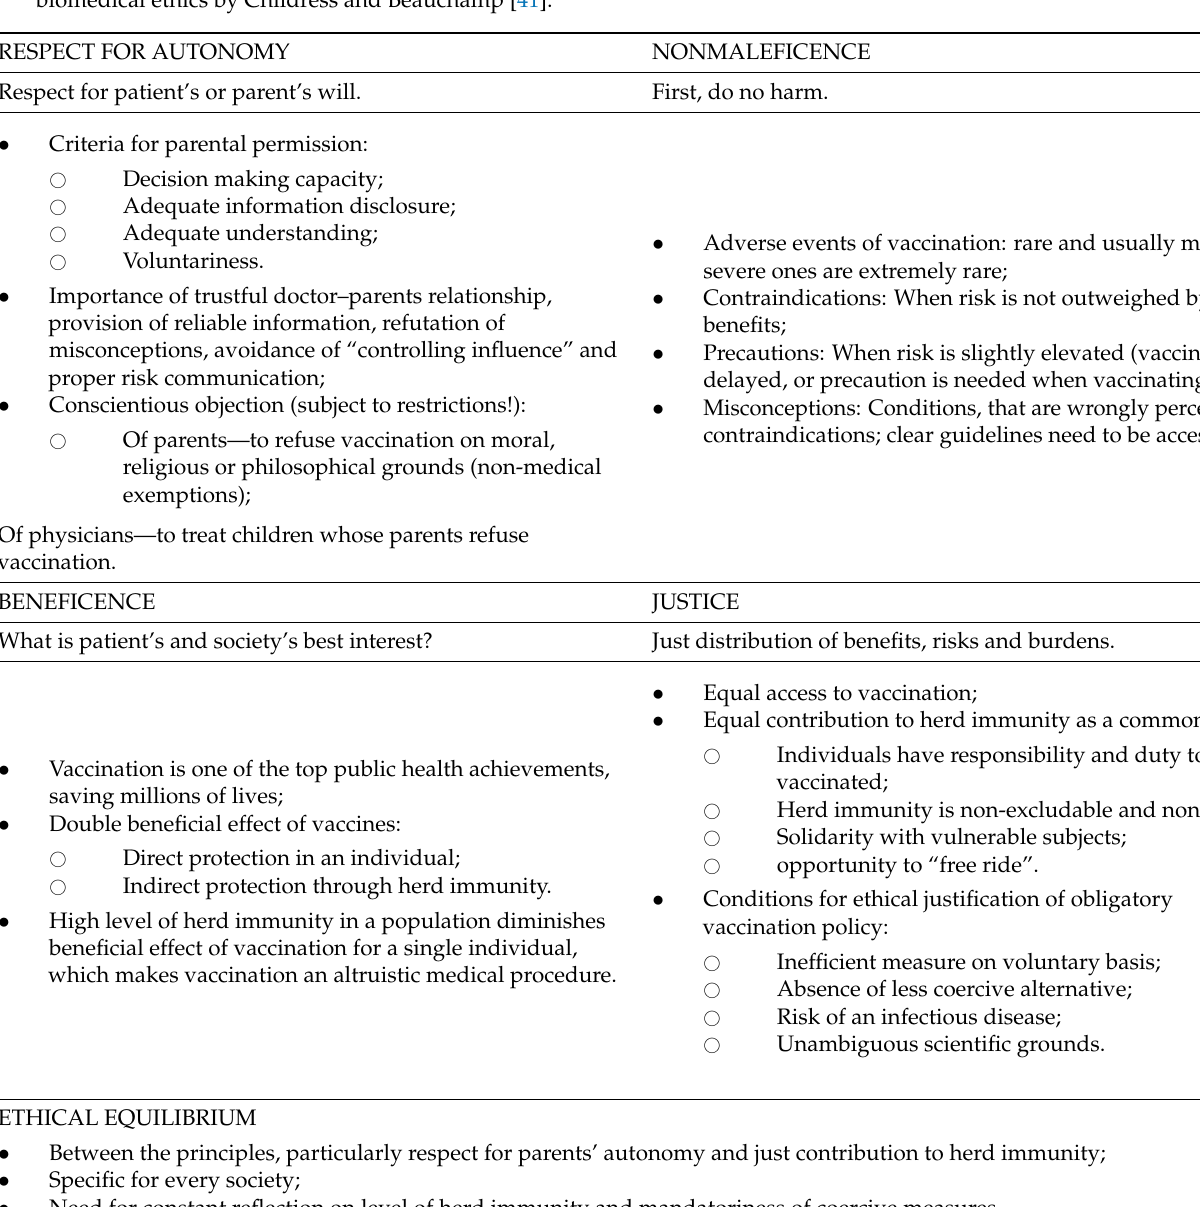
Table 1. A summary of a framework for ethical analysis of vaccination in childhood based on the four principles of biomedical ethics by Childress and Beauchamp